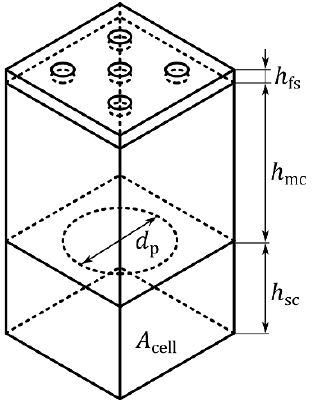
Figure 5. Schematic view of a single FHR cell.